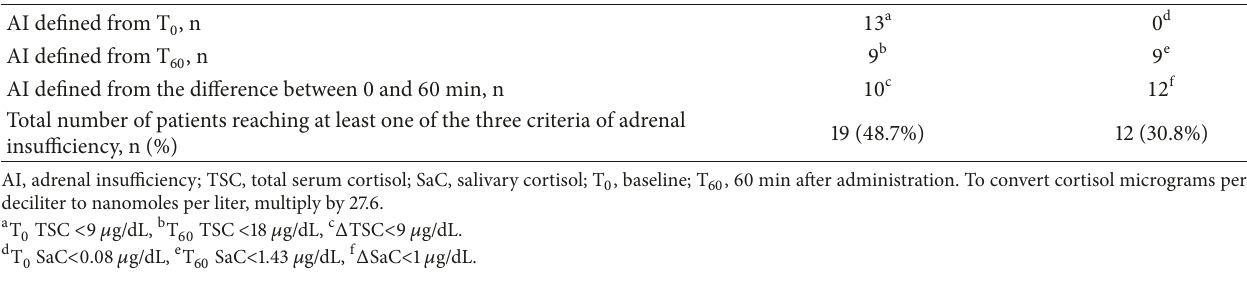
Table 7: Number of cirrhotic patients meeting at least one criterion for the diagnosis of AI based on serum cortisol and salivary cortisol thresholds during 250 𝜇 g ACTH test (N=39).